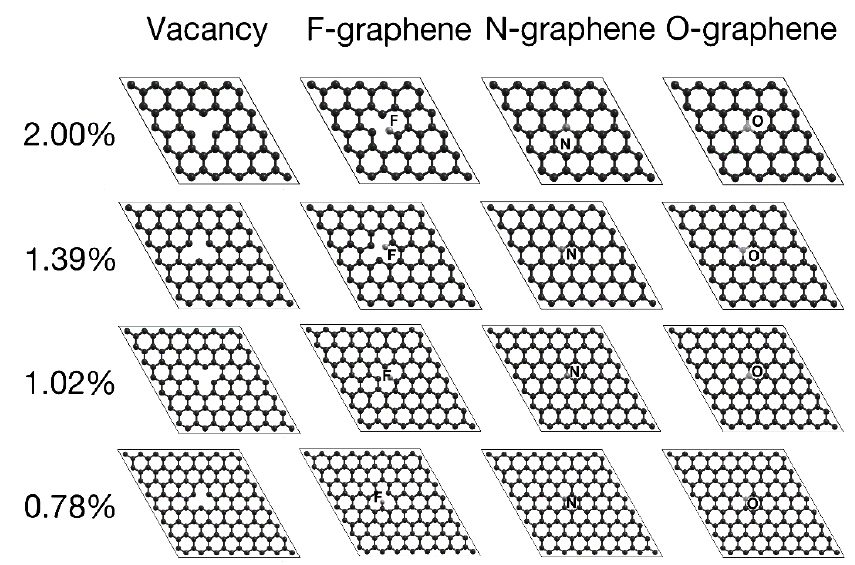
Figure 2. Top view of the XY plane for graphene with vacancy/dopant at: 2%, 1.39%, 1.02%, and 0.78%. We mark the boundaries of the unit cells with lines.